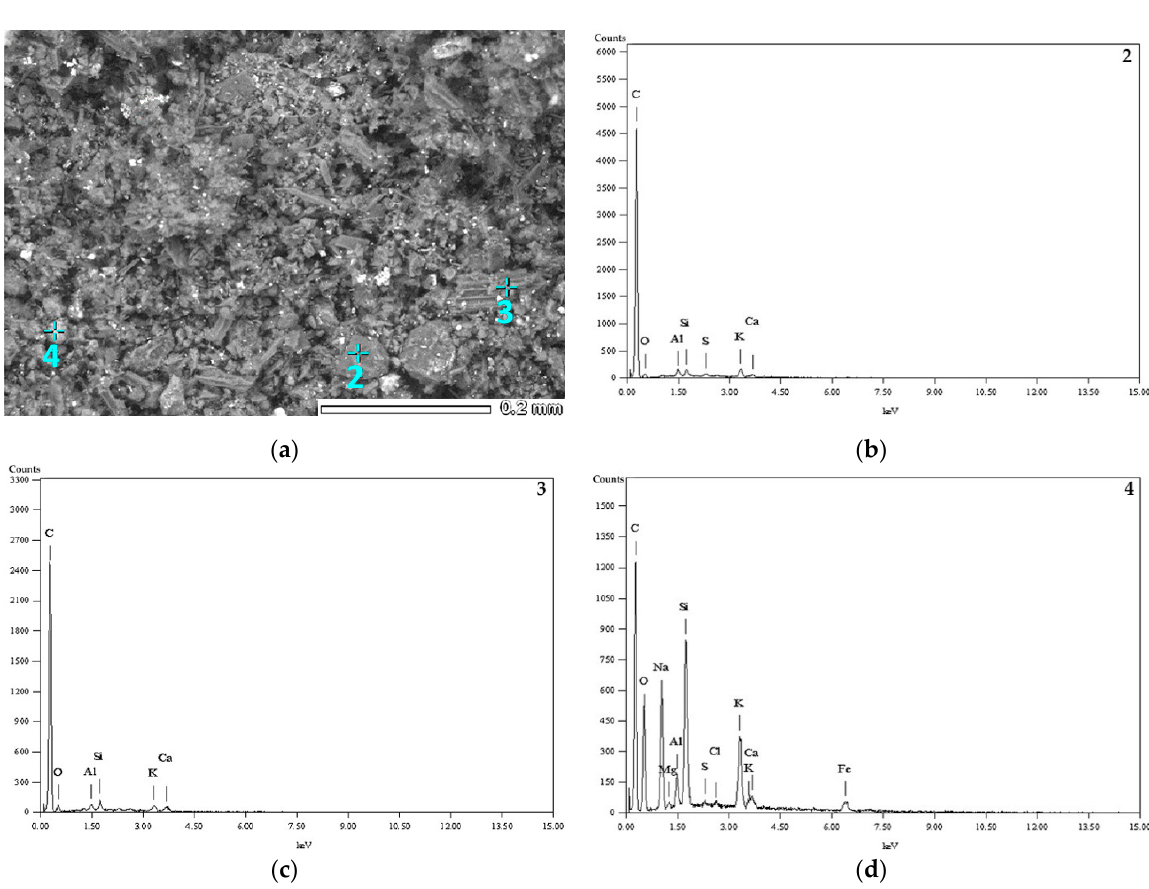
Figure 4. Dispersion energy spectrum of X-rays (EDS) for certain area (1) of activated carbon, ( a ) photo of analyzed sample of activated carbon; ( b ) spectrum.